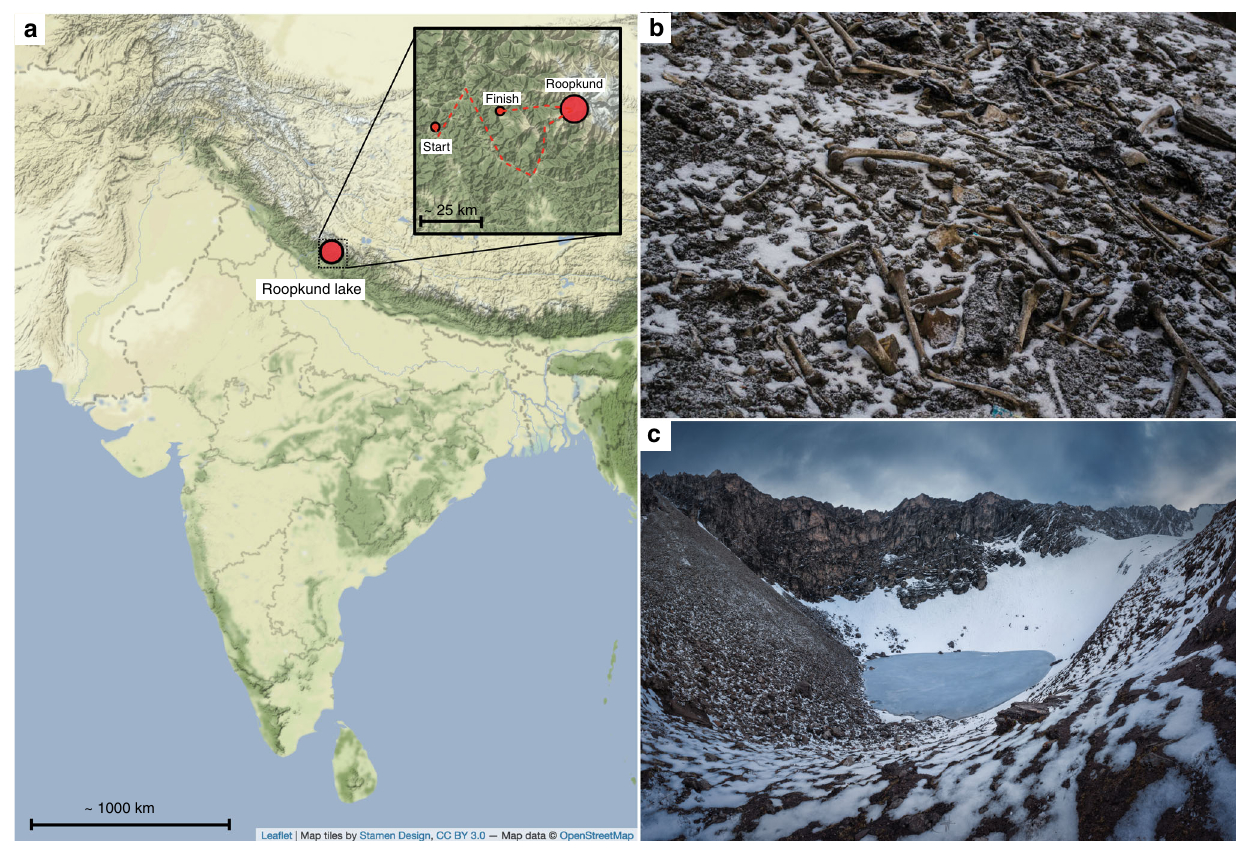
Fig. 1 Context of Roopkund Lake. a Map showing the location of Roopkund Lake. The approximate route of the Nanda Devi Raj Jat pilgrimage relative to Roopkund Lake is shown in the inset. b Image of disarticulated skeletal elements scattered around the Roopkund Lake site. Photo by Himadri Sinha Roy. c Image of Roopkund Lake and surrounding mountains. Photo by Atish